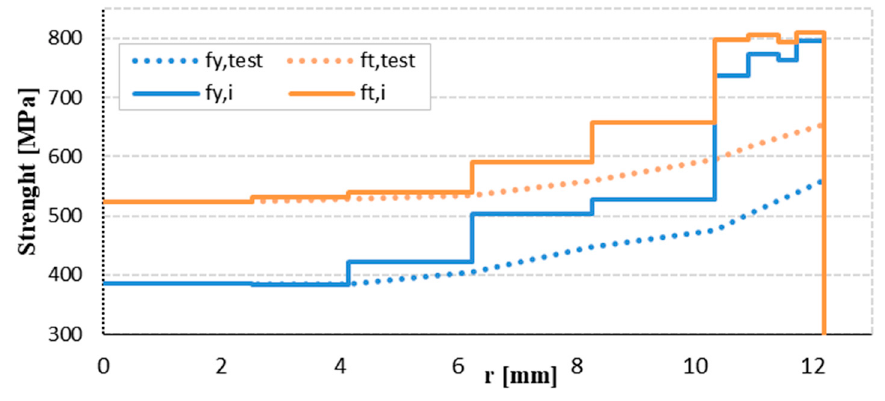
Figure 5. The yield and tensile strength considering the layers ( φ 25A). Table 2. Mechanical properties of tensile tests.